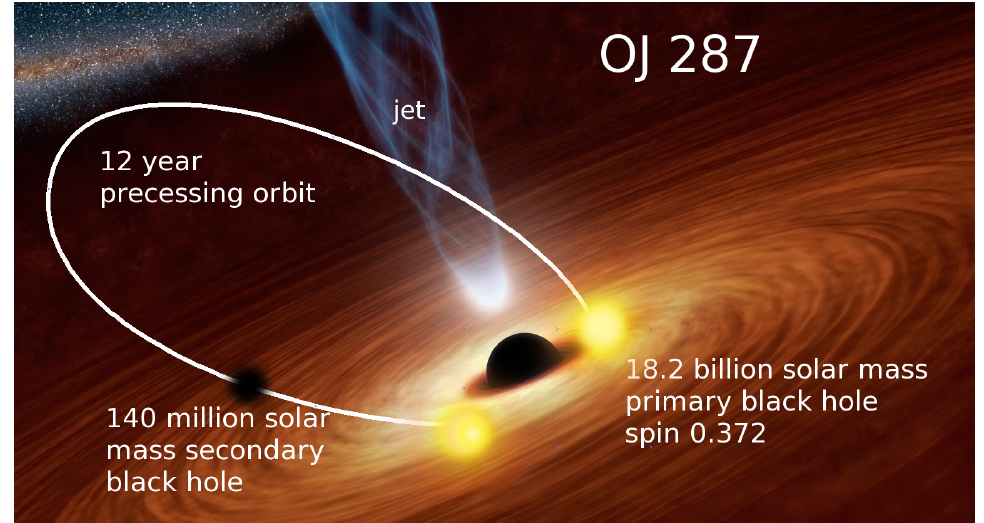
Figure 1. The improved inspiraling binary black hole central engine model for OJ 287. The current period of 12.055 year decreases by 38 days per century (Dey et al. 2017